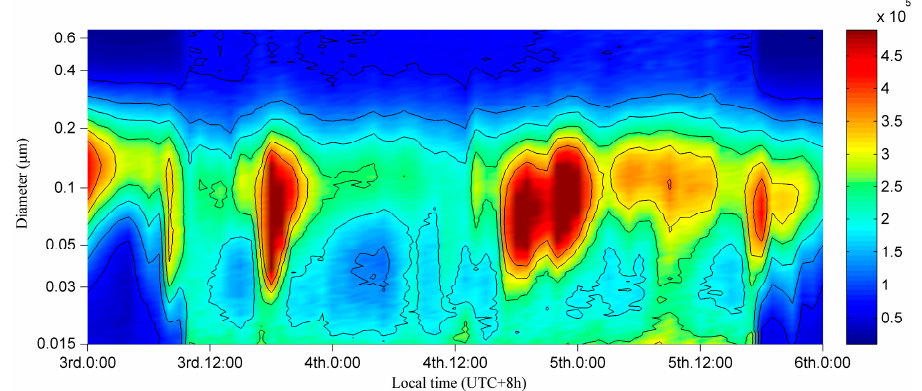
Figure 5. Contour plot of the size distribution of number concentration, d(cid:1840)/dlog (cid:1830) (cid:3043) in cm − 3 on three consecutive winter days from 3 January to 5 January 2014.